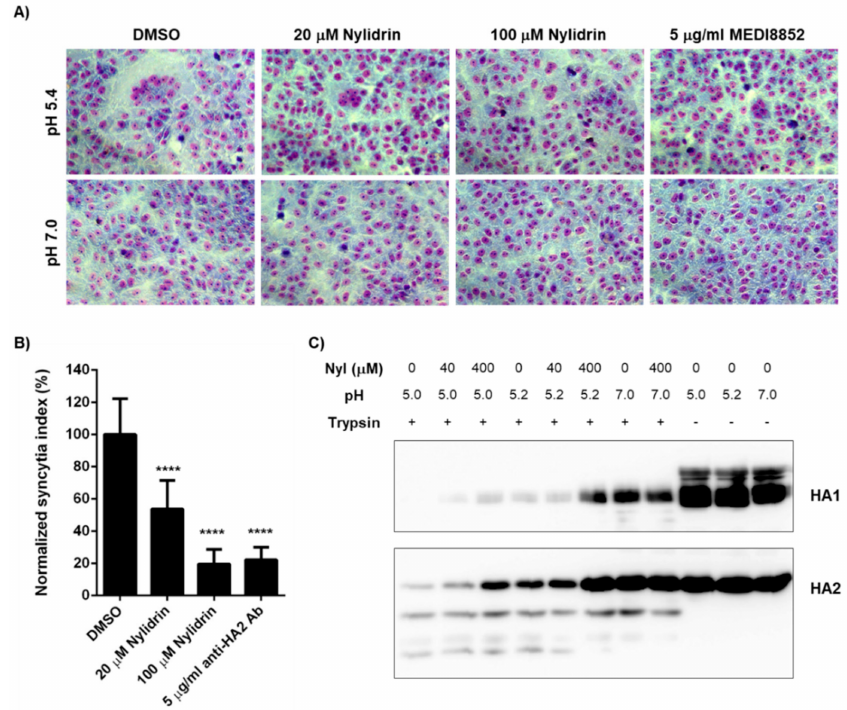
Figure 4. Inhibition of influenza HA2-mediated membrane fusion by nylidrin. ( A ) Polykaryon formation assay. PR8-infected Vero E6 cells (MOI, 1) were incubated under acidic (pH 5.4) or neutral (pH 7.0) conditions for 15 min at 37 ◦ C in the presence of nylidrin (20 or 100 µ M) or the anti-HA2 antibody MEDI8852 (5 µ g / mL). After syncytium formation for additional 3 h at neutral pH, the cells were fixed and stained with Giemsa for microscopic analysis (200 × ). ( B ) Percentages of syncytium formation relative to the DMSO-treated control from 16 non-overlapping images; ****, p < 0.0001. Statistical comparisons were performed using a two-tailed unpaired t -test. ( C ) Tryptic digestion assay. PR8 virus (5.5 × 10 7 PFU) was incubated with DMSO or nylidrin (40 or 400 µ M) for 20 min. Under acidic (pH 5.0 or 5.2) or neutral (pH 7.0) conditions, the samples were individually incubated for 15 min. After neutralizing with Tris-HCl (pH 9.0), they were treated with ( + ) or without (-) trypsin for 1 h and subjected to western blot analysis to detect viral HA1 and HA2 proteins. Uncleaved proteins by